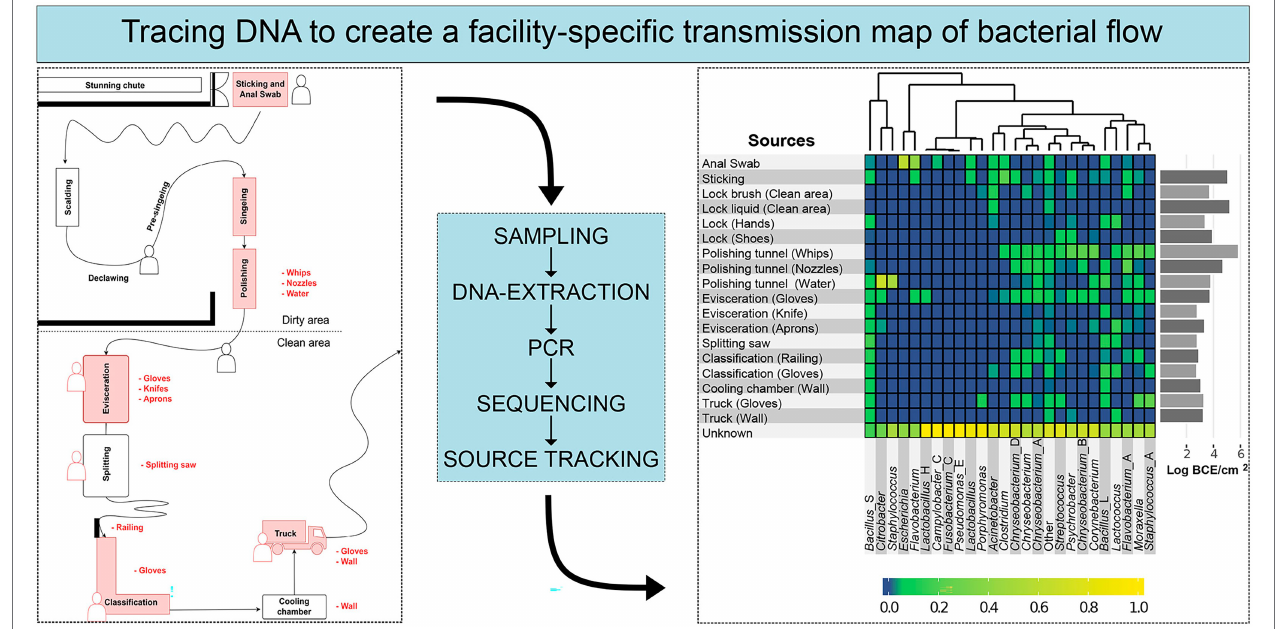
FIGURE 5 | Schematic workflow describing microbial source tracking in slaughter facilities based on 16S rRNA gene amplicon HTS. The left box illustrates a schematic map of a meat processing plant with sampling areas marked in red. The right box shows the final result, a heatmap with the predicted relative contribution of specific genera from the sampled source environments. The figure was modified from Zwirzitz et al. (2020) published under http://creativecommons.